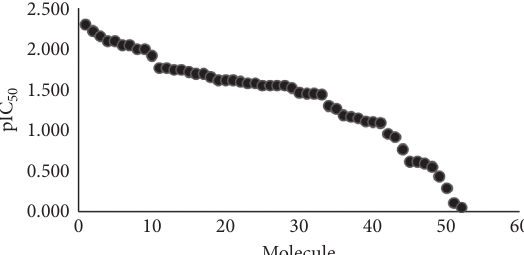
Table 8: Observed and predicted values of pIC